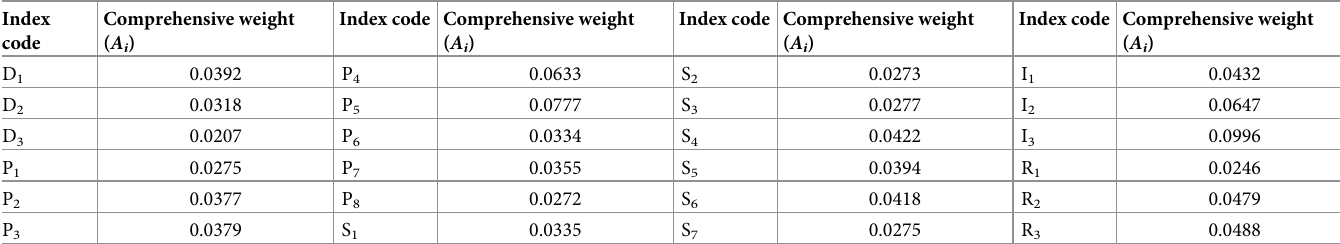
Table 10. Comprehensive weight of the indexes.